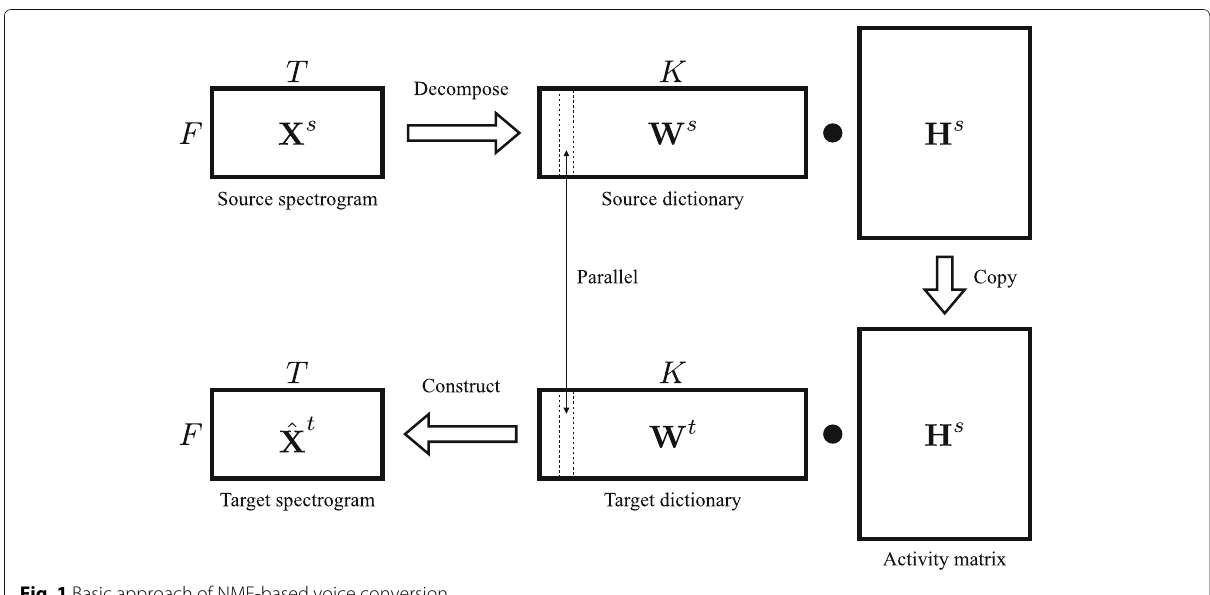
Fig. 1 Basic approach of NMF-based voice conversion